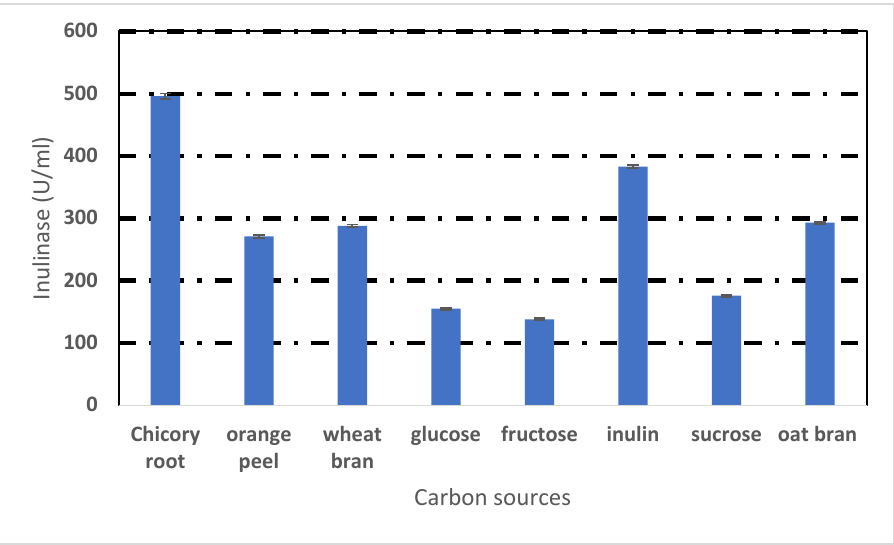
Figure 1. Production of inulinase enzyme on various carbon sources by Rhizopus oryzae NRRL 3563.